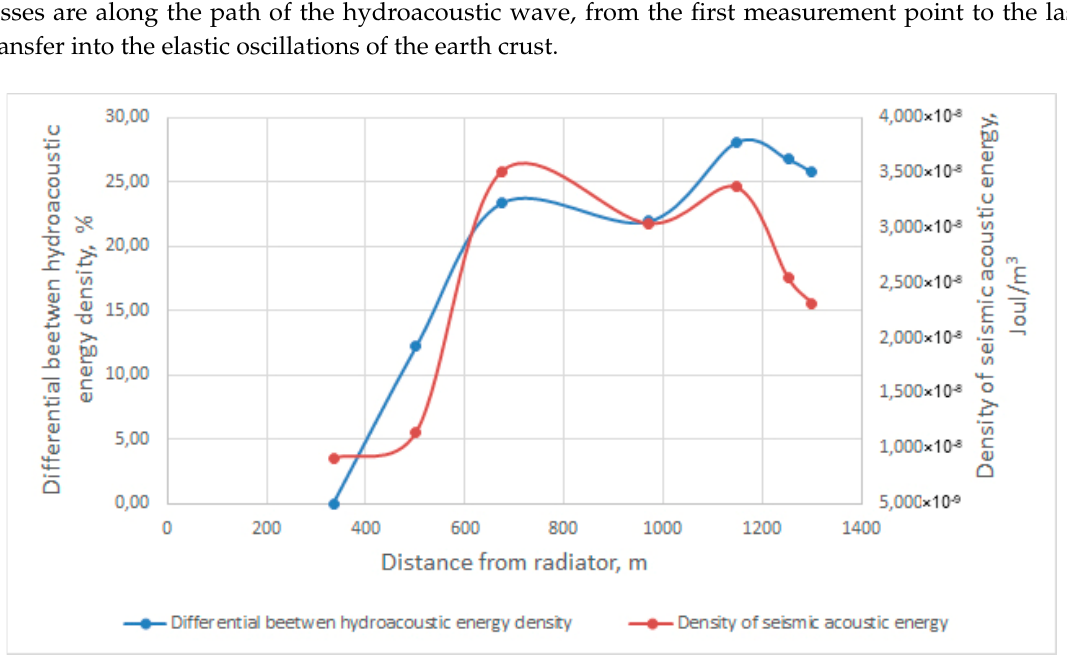
Figure 9. Graphs of the energy density of the seismoacoustic wave recorded by the laser strainmeter, and the difference in the energy density of the experiment and the cylindrical divergence in percent.